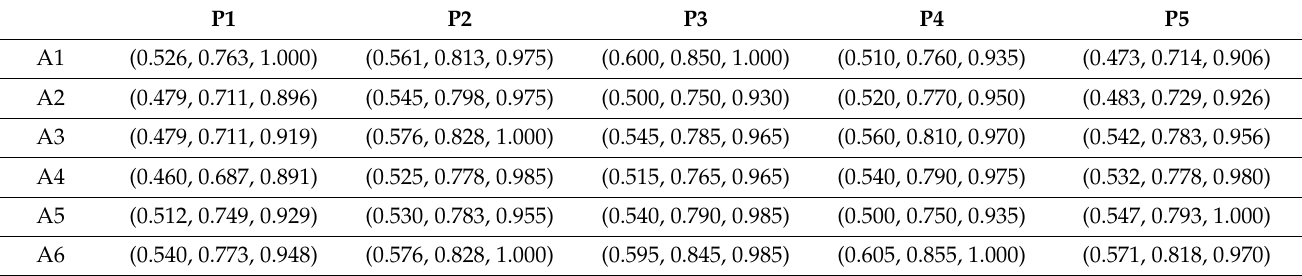
Table 5. A normalized decision matrix.